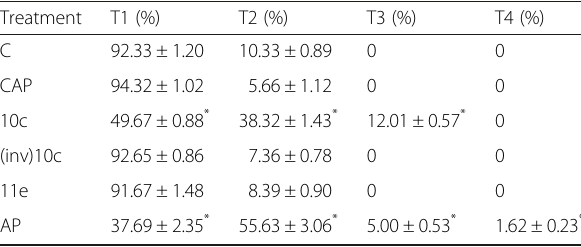
Table 1 Semi-quantitative histological assessment